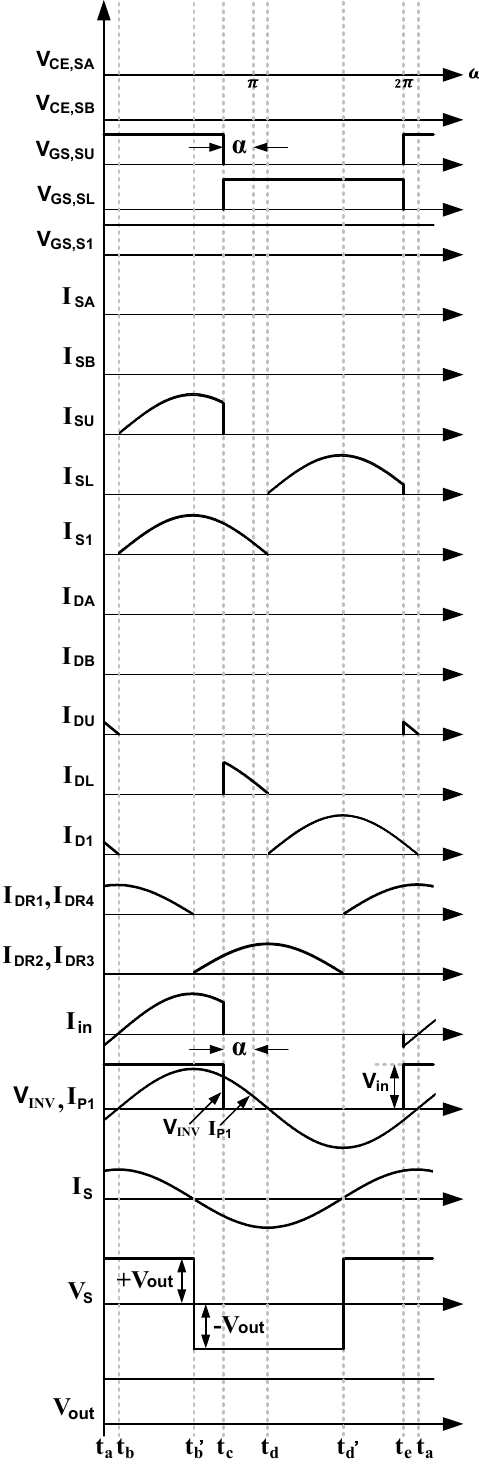
Figure 3. Timing diagram and theoretical waveforms of the normal mode.